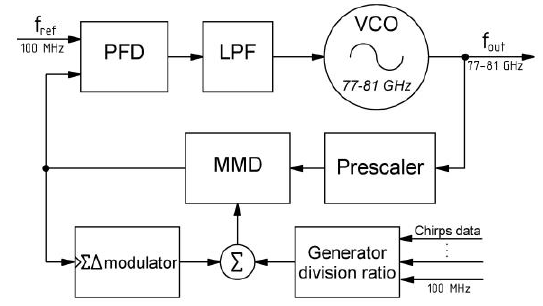
Fig. 1. Block diagram of the FMCW synthesizer.